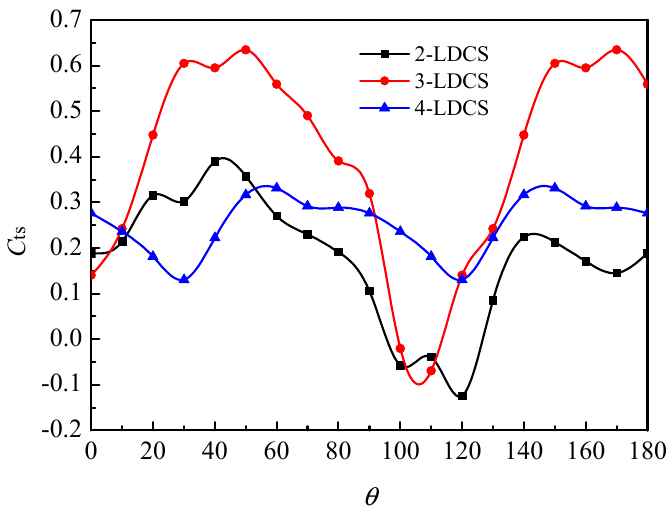
Figure 20. Curves of LDCS static torque coefficients of three numbers of blades with azimuth angle ( U = 10 m/s).